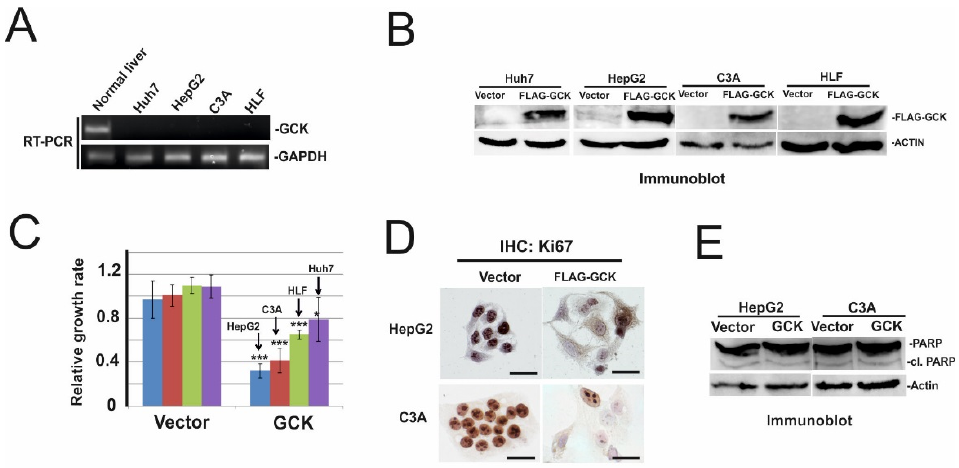
Figure 3. Overexpression of GCK inhibited cell proliferation. ( A ) Total RNAs from normal human liver (Origene), Huh7, HepG2, C3A, and HLF cells were used to examine the expression of GCK. glyceraldehyde-3 phosphate dehydrogenase (GAPDH) was used as the loading control. ( B ) Control vector (Vector) and FLAG-tagged GCK (FLAG–GCK) were overexpressed in Huh7, HepG2, C3A, and HLF cells. Two days after transfection, total cell lysates were applied for FLAG and actin-specific immunoblot. Actin was used as the loading control. ( C ) Sister cultures of (B) were subjected to crystal violet assay. Numbers are mean ± SD. ***: p -value < 0.001, *: p -value < 0.05. ( D ) HepG2 and C3A cells were transfected with the control vector and FLAG–GCK. Two days after transfection, cells were fixed in ice-cold methanol and stained with Ki67 specific antibody by IHC (immunohistochemistry) technique. Representative images were shown. Bars represent 50 µm. ( E ) Sister culture of ( D ) was subjected to PARP and actin-specific immunoblotting. Actin was used as the loading control.